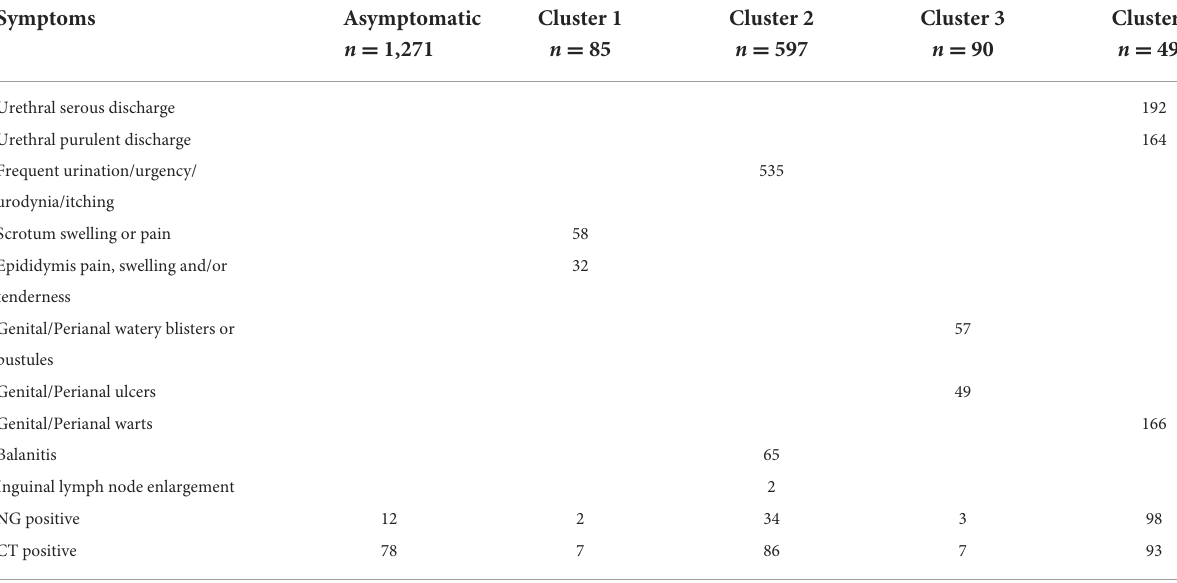
TABLE 1 Symptom clusters of the respondents in the men cohort ( N = 2,536).